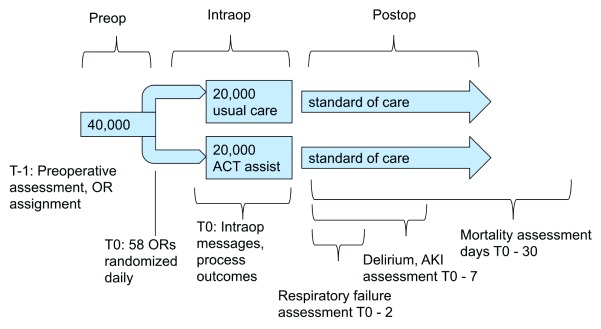
Schematic of study design, patient activity flow.